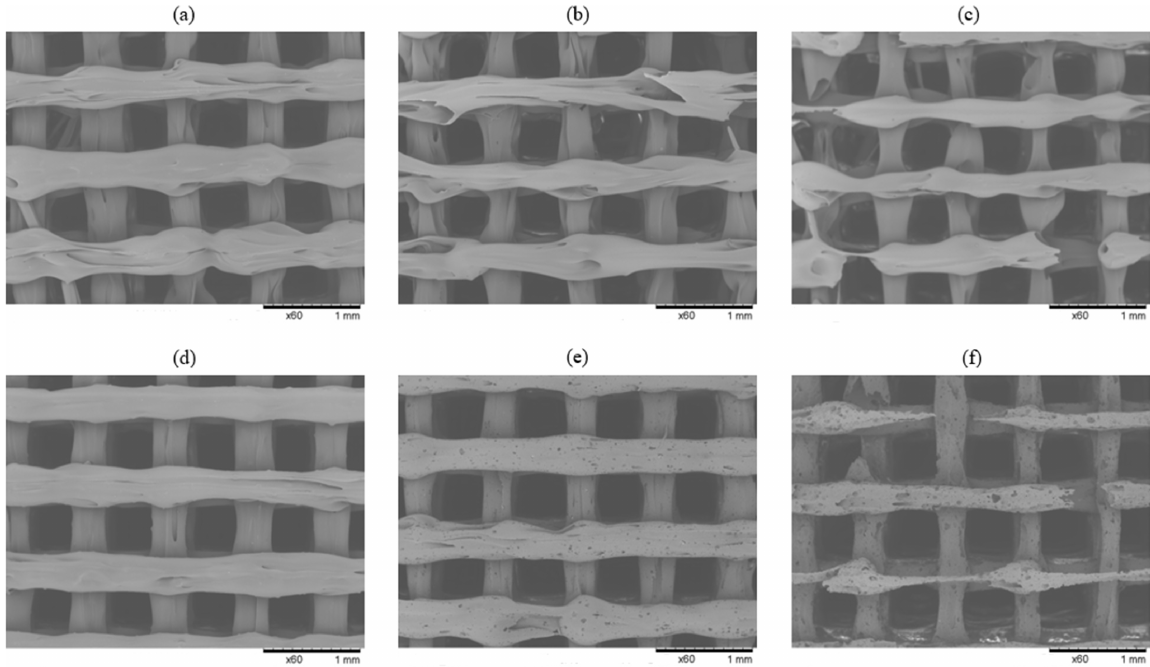
Figure 2: SEM images of the scaffolds analyzed: (a) PLA; (b) PLA 5D; (c) PLA 10D; (d) Composite; (e) Composite 5D; (f) Composite 10D. Scale bar: 1 mm.